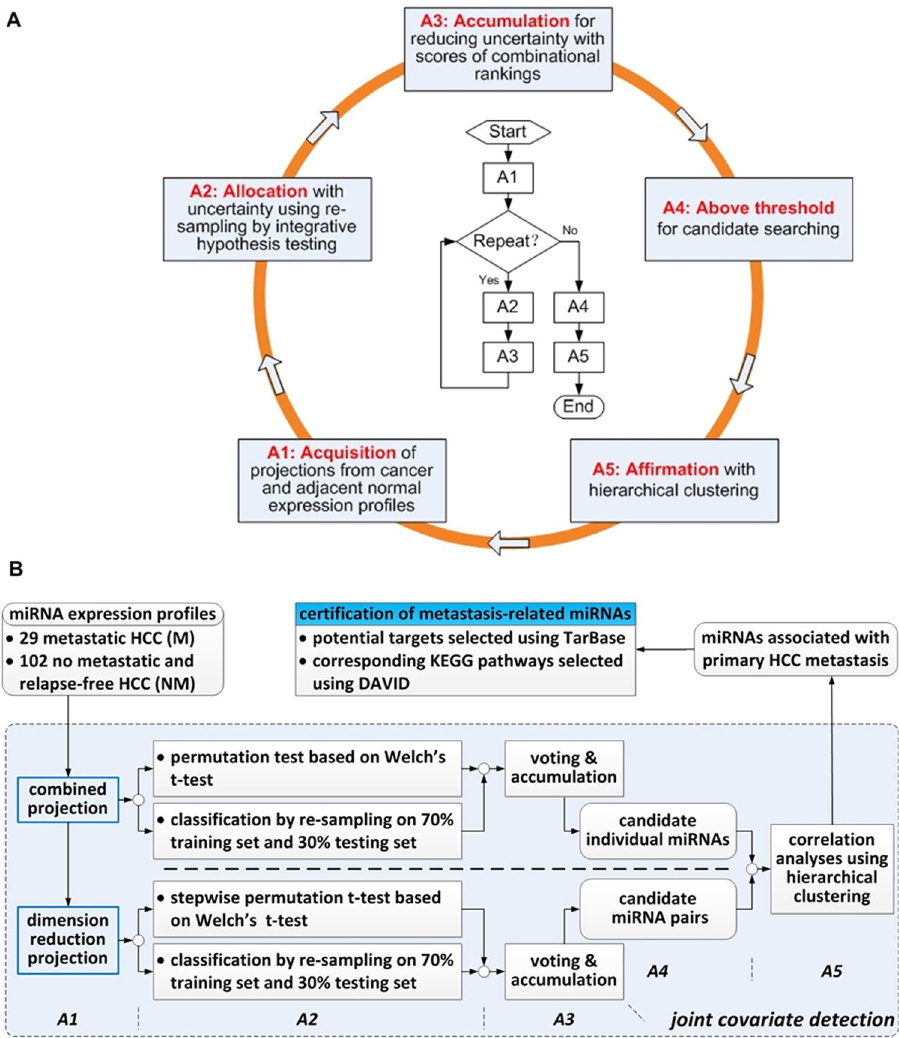
Figure 1. Selection schematic of metastasis-related miRNAs. Panel (A) represents a bilinear A5-based feature selection method. Panel (B) denotes the corresponding joint covariate detection for identifying metastasis- related miRNAs in